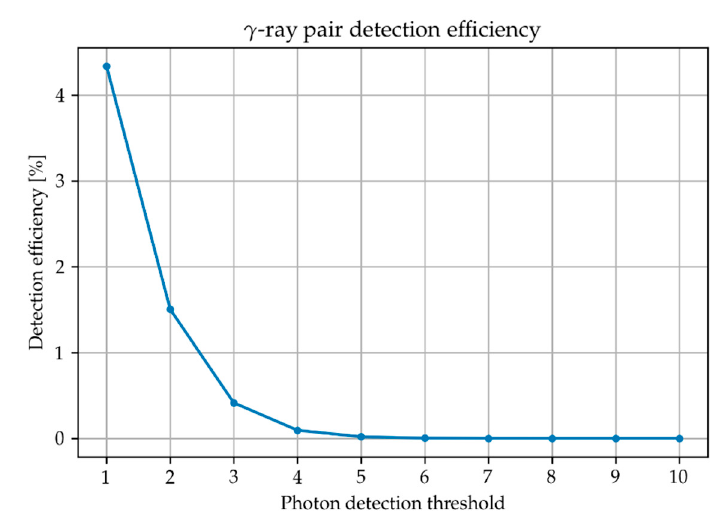
Figure 8. Detection efficiency of the paired Cherenkov detectors for the γ -ray pair emission.